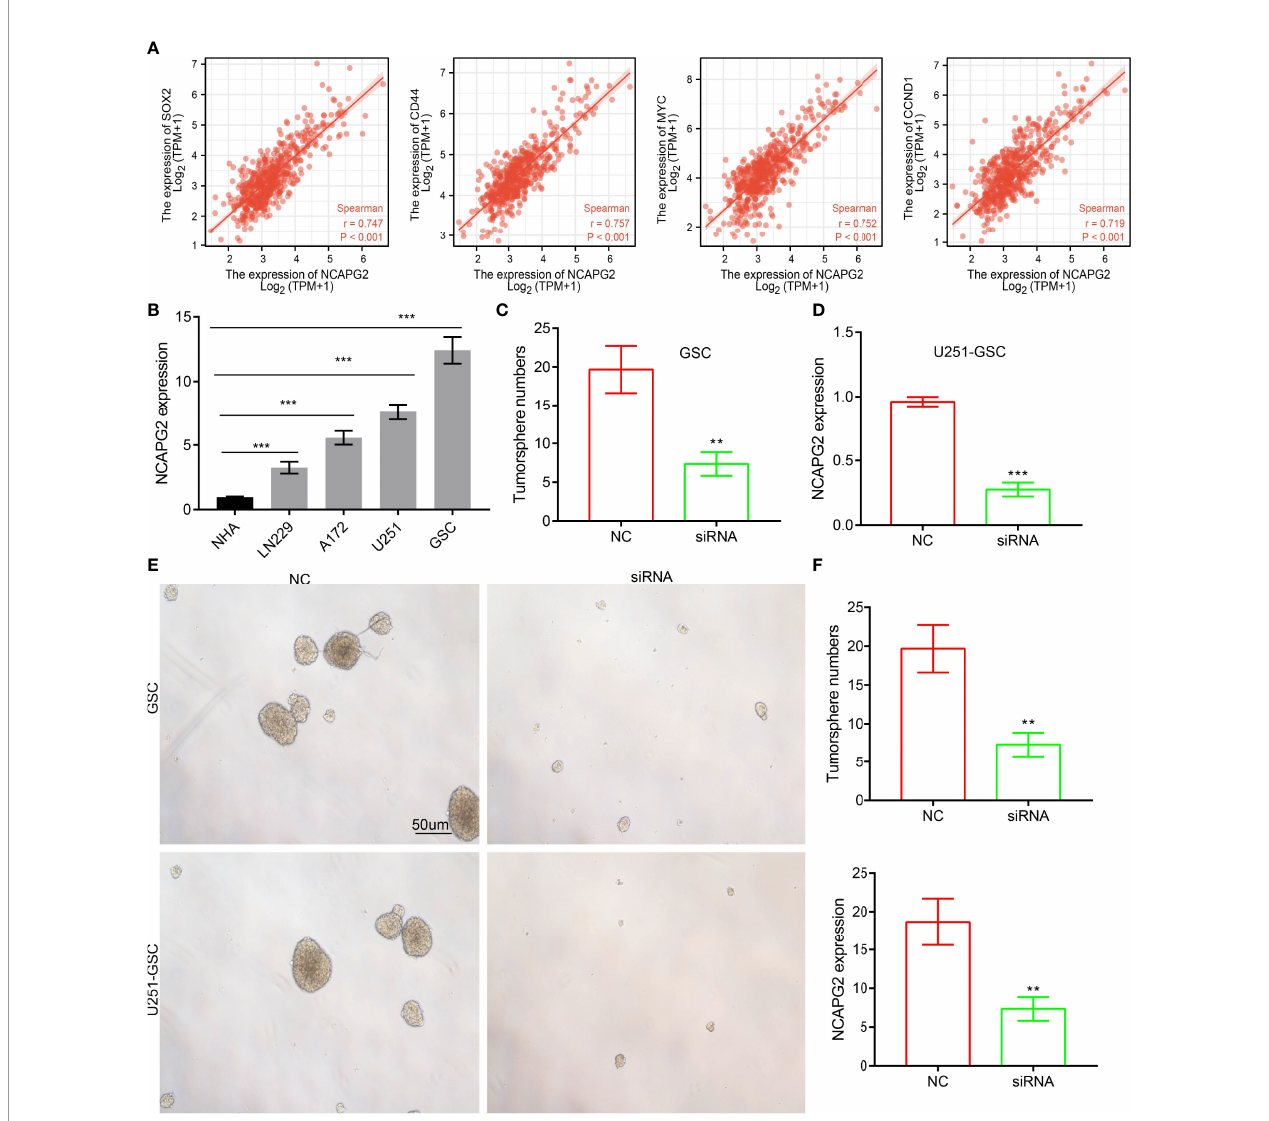
FIGURE 11 | Depletion of NCAPG2 inhibits the self-renewal ability of GSC. (A) Correlation between NCAPG2 expression and glioma stem cell marker genes, including Sox2, CD44, MYC and CCND1. (B) The expression of NCAPG2 in normal human astrocytes cells (NHA) and GBM cell lines. (C, D) The qRT-PCR assay showed that the expression of NCAPG2 mRNA was signi fi cantly decreased in U251-GSC and GSC cells after treatment with targeted siRNA. (E, F) NCAPG2 knockdown signi fi cantly inhibited GSC the self-renewal ability. P < 0.01 (**) and P < 0.001